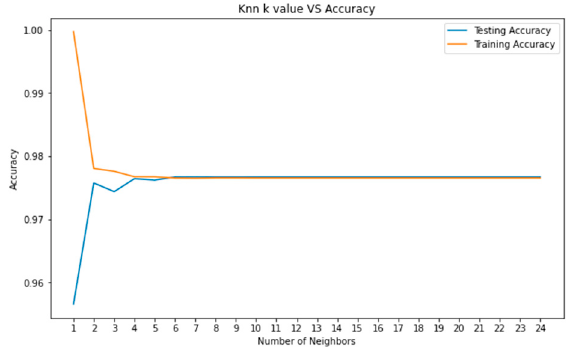
Table 5. Experimental results of proposed method.